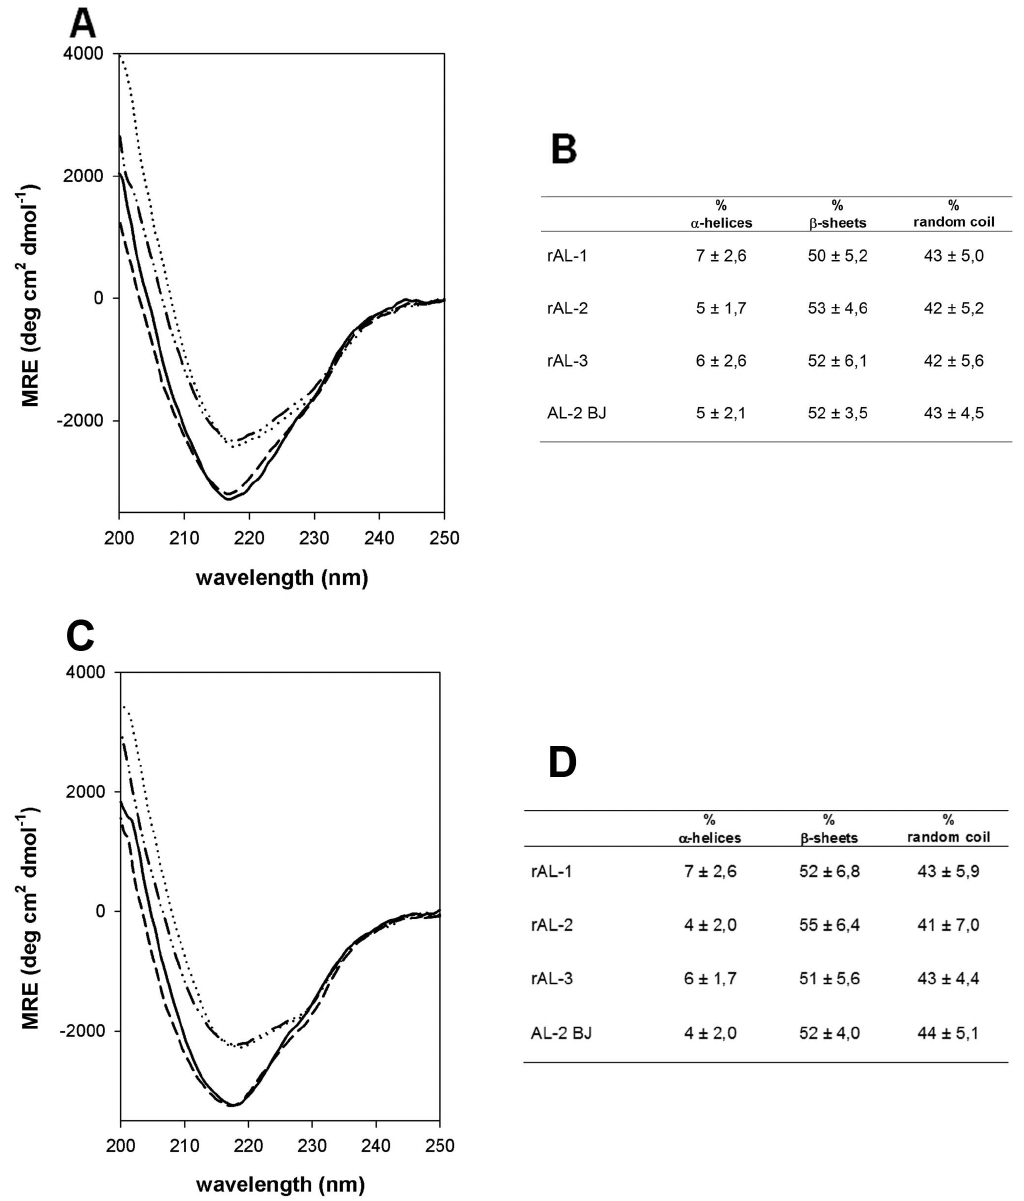
Figure 5. Circular dichroism analyses. Far-ultraviolet CD spectra (panel A, pH 7.4; panel C, pH 5.0) of purified rAL-1 (short dashes), rAL-2 (dotted), rAL-3 (solid) compared with the spectrum of patient AL-2 BJ protein (dash-dot-dot). Each CD spectrum represents the average of ten scans. Data are shown as mean residue ellipticity (MRE) as a function of wavelength. Panels B and D report the secondary structure content of the analyzed proteins (at pH 7.4 and 5.0, respectively), calculated with K2D, CDSSTR and CONTIN software applications. Data are expressed as mean 6 sd. Spectra were virtually identical for rAL-2 and the corresponding natural BJ (panels A and C), overlapping for the other two rLC (94% amino acid identity), and display the minimum at around 218 nm, characteristic of b -sheets. Proteins showed very similar percentage of secondary structures. nucleotides (Figure 1). The universal l reverse primer was: 5 9 - resistance cassette, originally designed for cytoplasmic protein ATGGTAcgtctcAGCGCT TTATTA TGAACATTCTG- expression with C-terminal His-tag. The recombinant monoclonal TAGGGGCCACTG-3 9 , which included Bsm BI recognition site LC (Figure 1) was obtained via PCR reamplification (94 u C, 5 sec; (lower case), and two stop codons (bold italic) after the last 65 u C, 45 sec; 72 u C, 45 sec; 30 cycles) of the V L + C L cDNA, using monoclonal LC constant region nucleotide triplet (Figure 1). For primers designed according to the pASK-IBA protein cloning k LC expression the following universal reverse primer is adopted: strategy, which requires internal Bsm BI recognition sites both at the 5 9 and 3 9 primers (Figure 1). The patient-specific forward CACTCTCCCCTGTTGAAGCT-3 9 . After Bsm BI digestion, primer was: 5 9 -ATGGTAcgtctcAA ATG- patient-specific V L nu- each PCR product was ligated into Bsa I/ Bsa I sites of the cleotides-3 9 , which included Bsm BI recognition site (lower case), expression vector pASK-IBA33plus (Figure 1). Plasmid amplifica- initiation codon (bold) and patient-specific V L + 1 to + 22